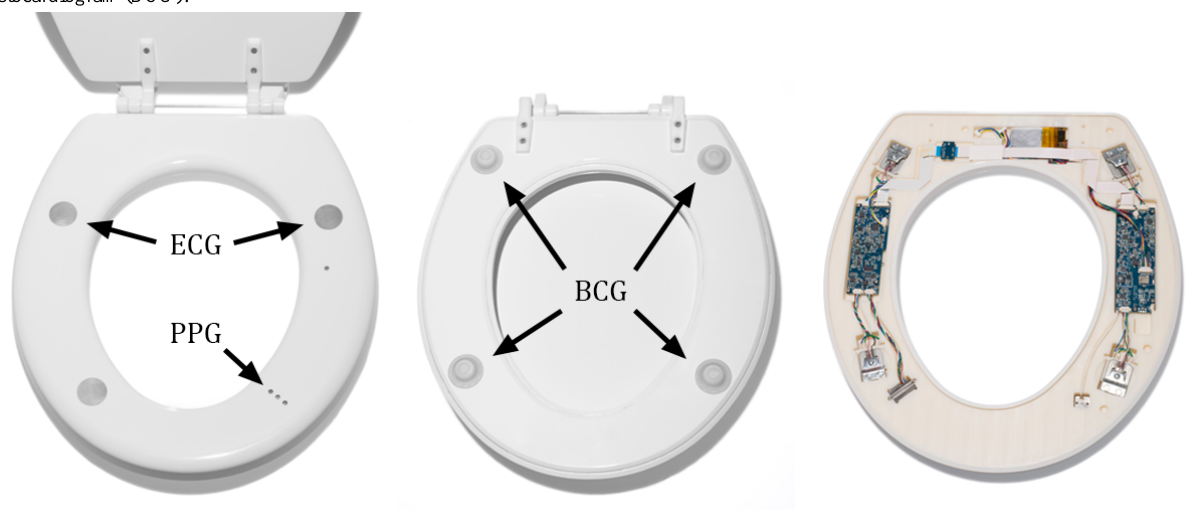
Figure 2. The toilet seat–based cardiovascular monitoring system is completely self-contained, battery-powered, wireless, and cleanable with all sensors and electronics instrumentation integrated inside of the seat. It can measure the electrocardiogram (ECG), photoplethysmogram (PPG), and the ballistocardiogram